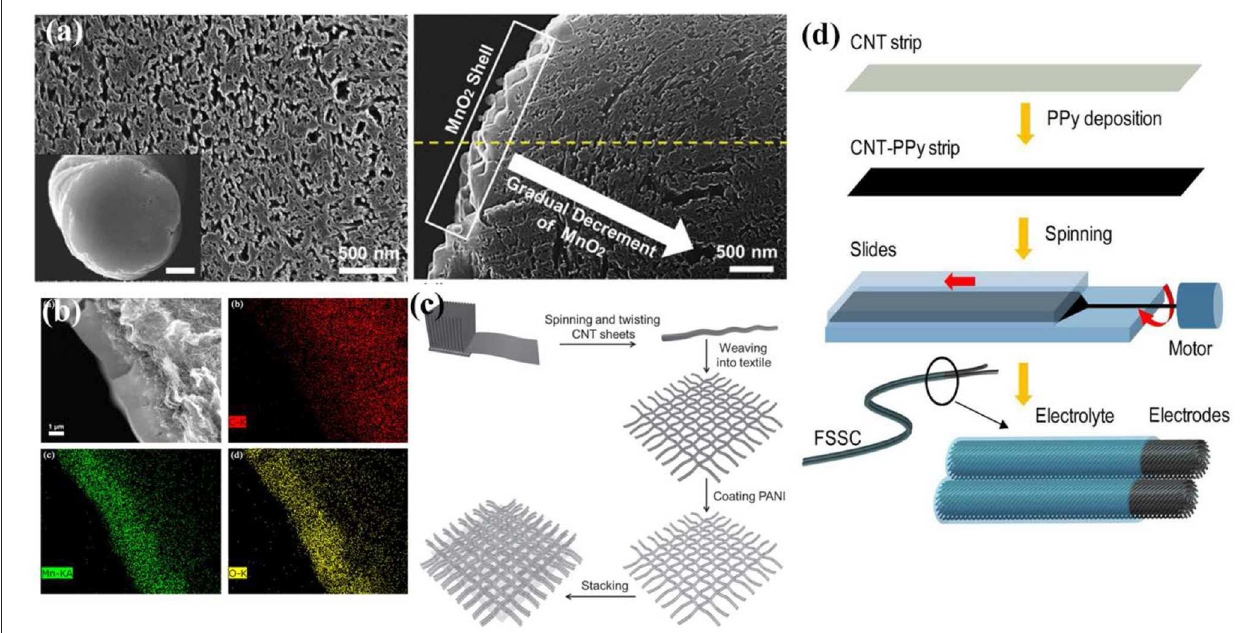
FIGURE 7 | Cross section morphologies of (a) the solid-spun CNT fiber with electrodeposited MnO 2 nano-particles (Choi et al., 2014) and (b) EDS of each elements of deposited MnO 2 in wet-spun CNT fiber ( Lu et al., 2017), (c) schematic fabrication procedures of electrodeposited PANI/CNT textile supercapacitor (Pan et al., 2015), and (d) solid-spun CNT fiber from pre-deposited PPy carbon nanotube film (Xu et al.,